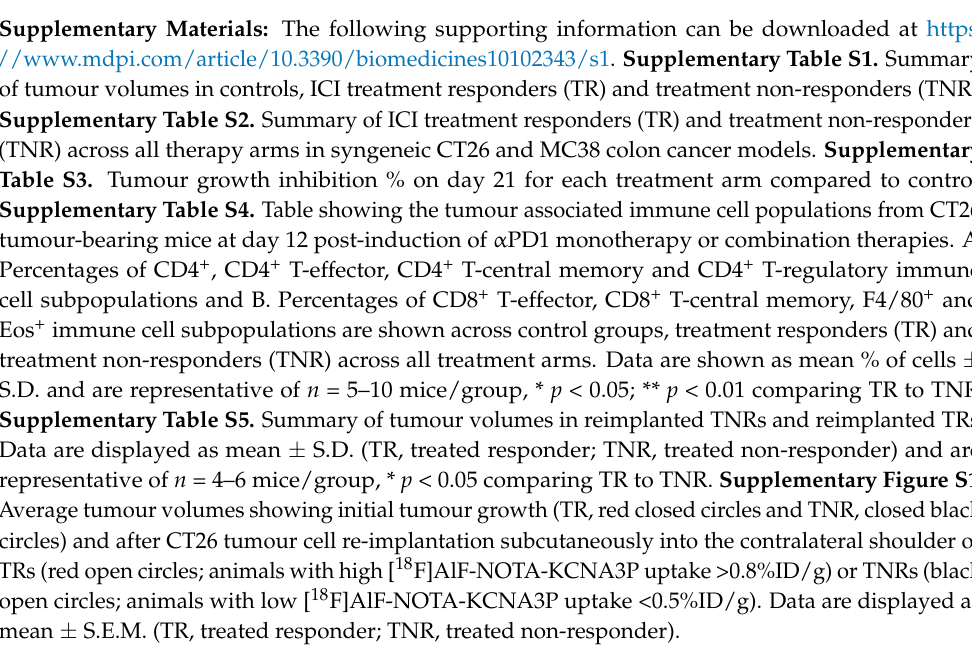
Supplementary Table S2. Summary of ICI treatment responders (TR) and treatment non-responders (TNR) across all therapy arms in syngeneic CT26 and MC38 colon cancer models. Supplementary Table S3. Tumour growth inhibition % on day 21 for each treatment arm compared to control. Supplementary Table S4. Table showing the tumour associated immune cell populations from CT26 tumour-bearing mice at day 12 post-induction of α PD1 monotherapy or combination therapies. A. Percentages of CD4 + , CD4 + T-effector, CD4 + T-central memory and CD4 + T-regulatory immune cell subpopulations and B. Percentages of CD8 + T-effector, CD8 + T-central memory, F4/80 + and Eos + immune cell subpopulations are shown across control groups, treatment responders (TR) and treatment non-responders (TNR) across all treatment arms. Data are shown as mean % of cells ± S.D. and are representative of n = 5–10 mice/group, * p < 0.05; ** p < 0.01 comparing TR to TNR. Supplementary Table S5. Summary of tumour volumes in reimplanted TNRs and reimplanted TRs. Data are displayed as mean ± S.D. (TR, treated responder; TNR, treated non-responder) and are representative of n = 4–6 mice/group, * p < 0.05 comparing TR to TNR. Supplementary Figure S1. Average tumour volumes showing initial tumour growth (TR, red closed circles and TNR, closed black circles) and after CT26 tumour cell re-implantation subcutaneously into the contralateral shoulder of TRs (red open circles; animals with high [ 18 F]AlF-NOTA-KCNA3P uptake >0.8%ID/g) or TNRs (black open circles; animals with low [ 18 F]AlF-NOTA-KCNA3P uptake <0.5%ID/g). Data are displayed as mean ± S.E.M. (TR, treated responder; TNR, treated